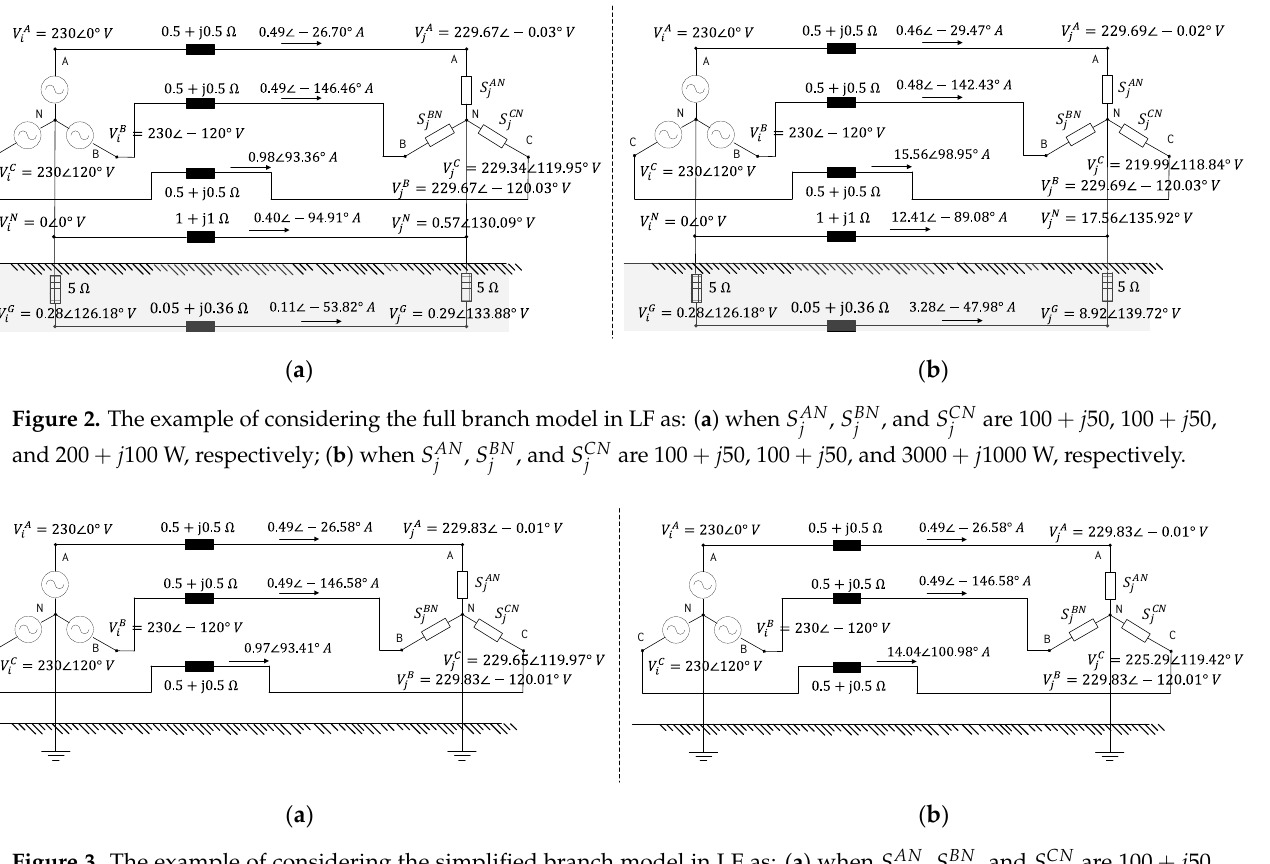
, S BN , and S CN are 100 + j 50, 100 + j 50, and 3000 + j 1000 W,